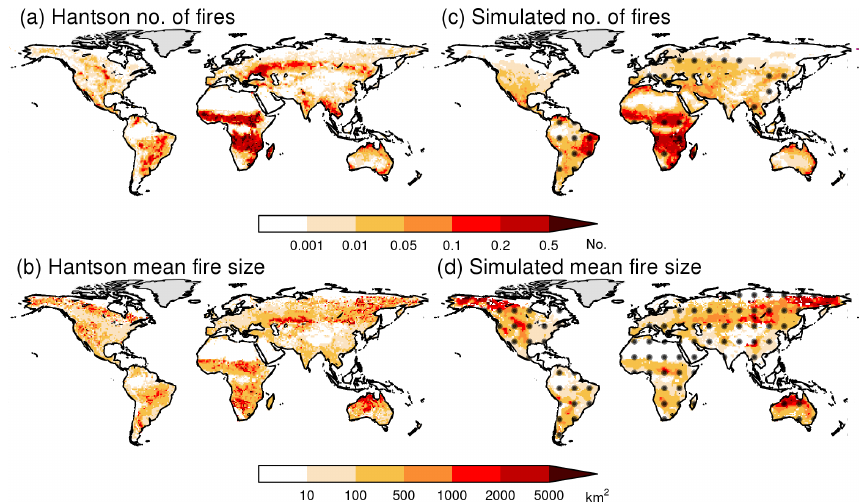
Figure 5. Reference datasets and mean of three models for number of fires and mean fire size. Model output is adapted so that mean and variance coincide with observations as the total values are not directly comparable. Stippling indicates where variance between models is less than the model ensemble